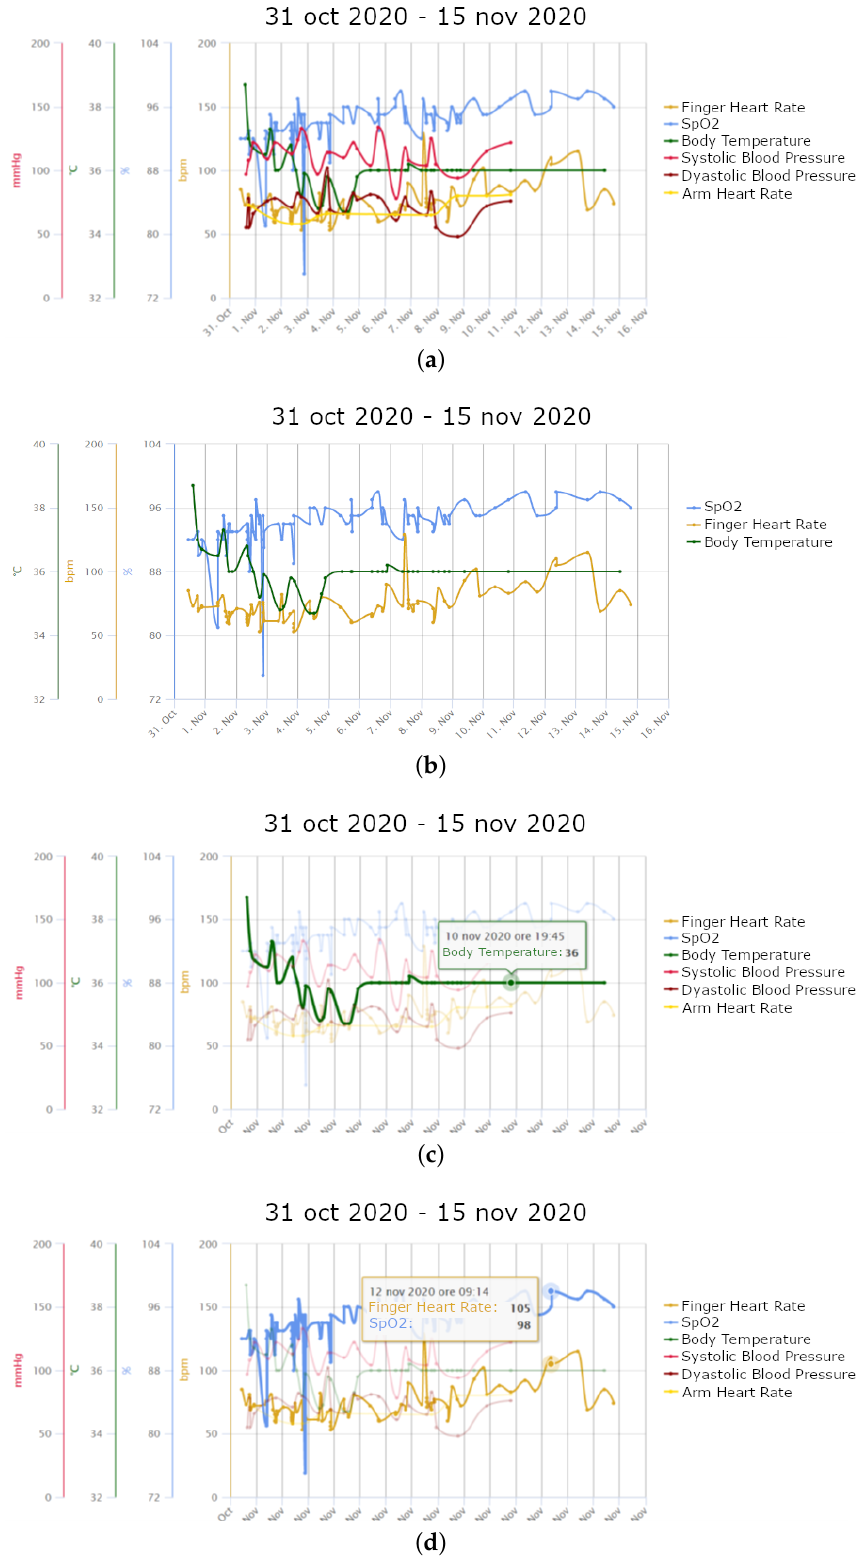
Figure 3. Trend of measurements of a patient aged 51 years without comorbidities: ( a ) all vital parameters; ( b ) SpO 2 , finger HR and body temperature; ( c ) highlighting of body temperature; ( d ) highlighting of SpO 2 and finger